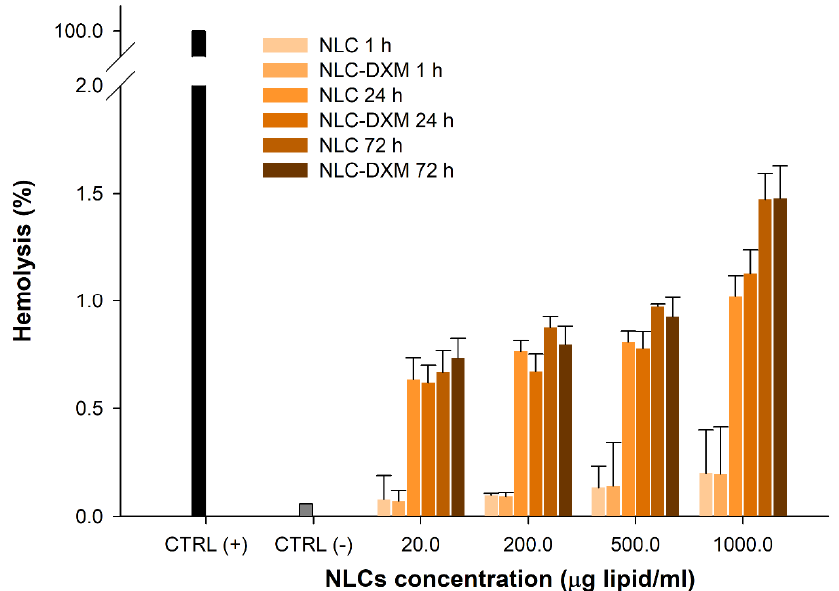
Figure 4. At high concentrations NLCs induce only minimal hemotoxicity. Hemotoxicity of empty and DXM loaded NLCs at different concentrations after 1, 24 and 72 h incubation. Controls: (−) untreated; (+) 1% Triton X-100-lysed erythrocytes, ( n = 3).